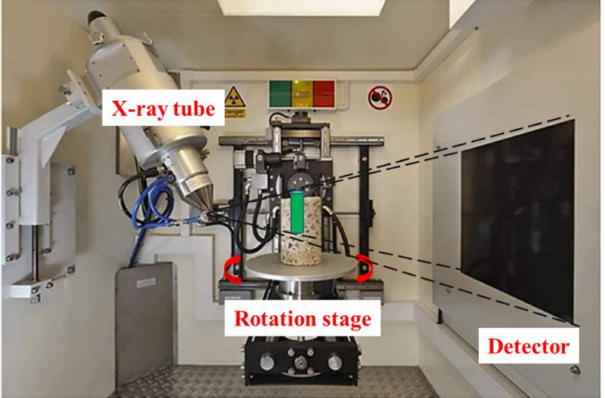
Figure 1. Example of an industrial computed tomography (CT) system.